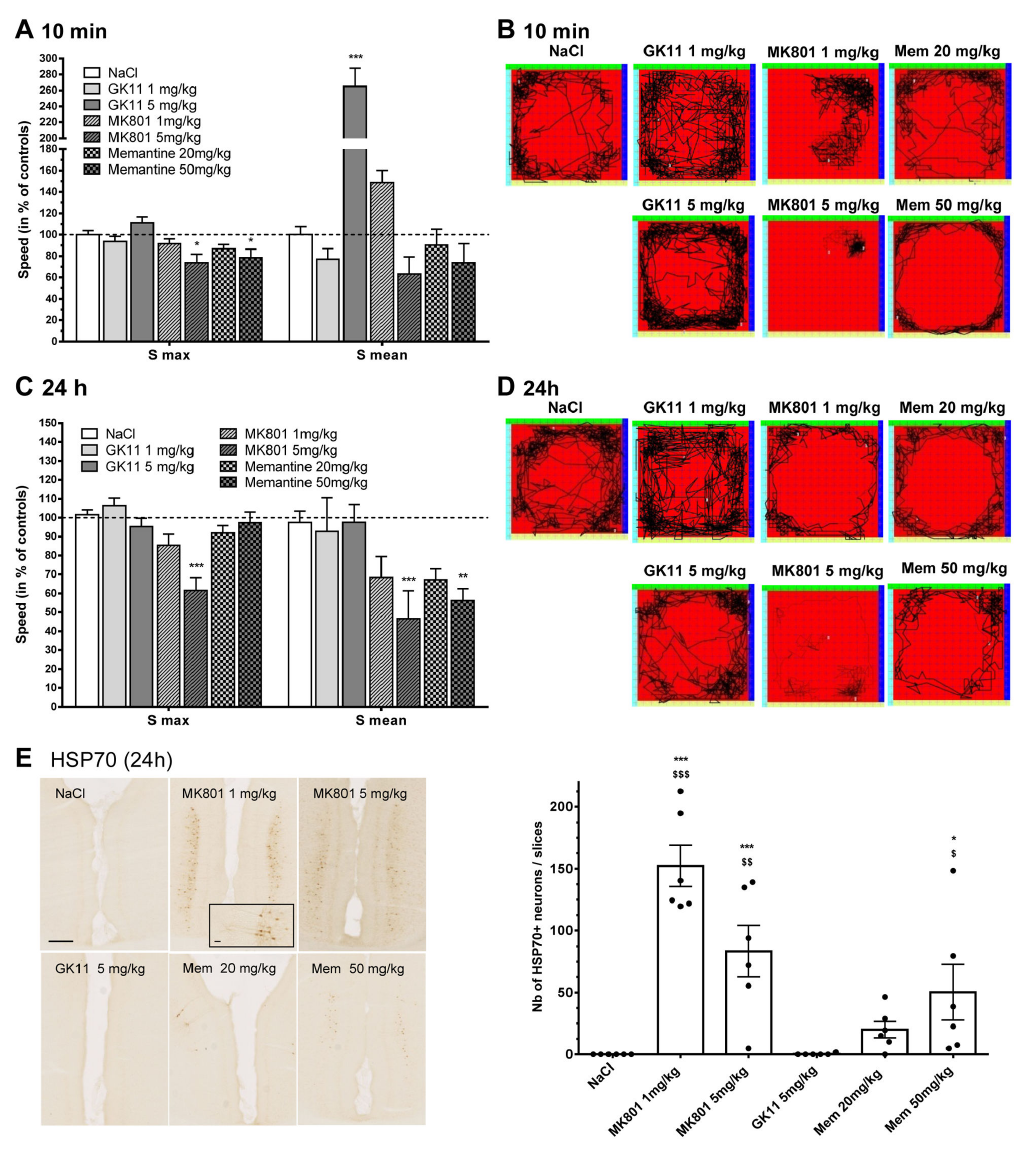
Figure 1. Acute and delayed effects of MK801, GK11 and Memantine treatment at the behavioural and